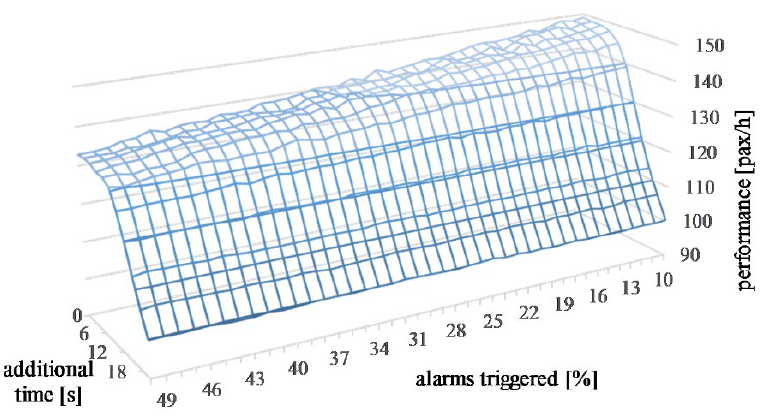
Figure 8. System performance sensitivity analysis for the assist time and percentage of alarms triggered for System Configuration